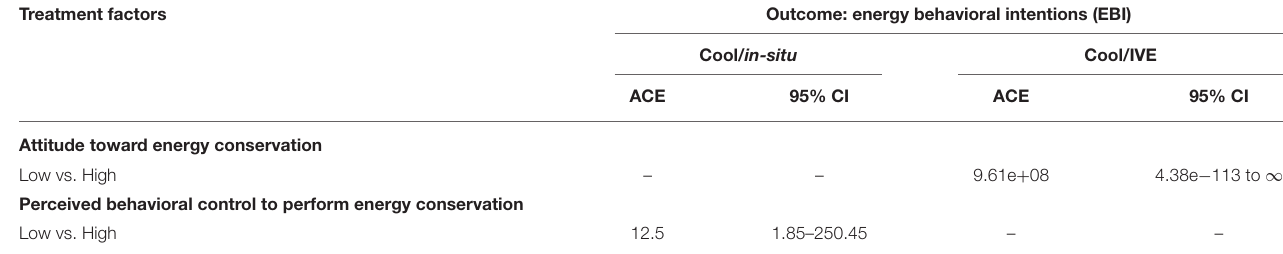
TABLE 3 | Average causal effect estimates of treatment factors influencing